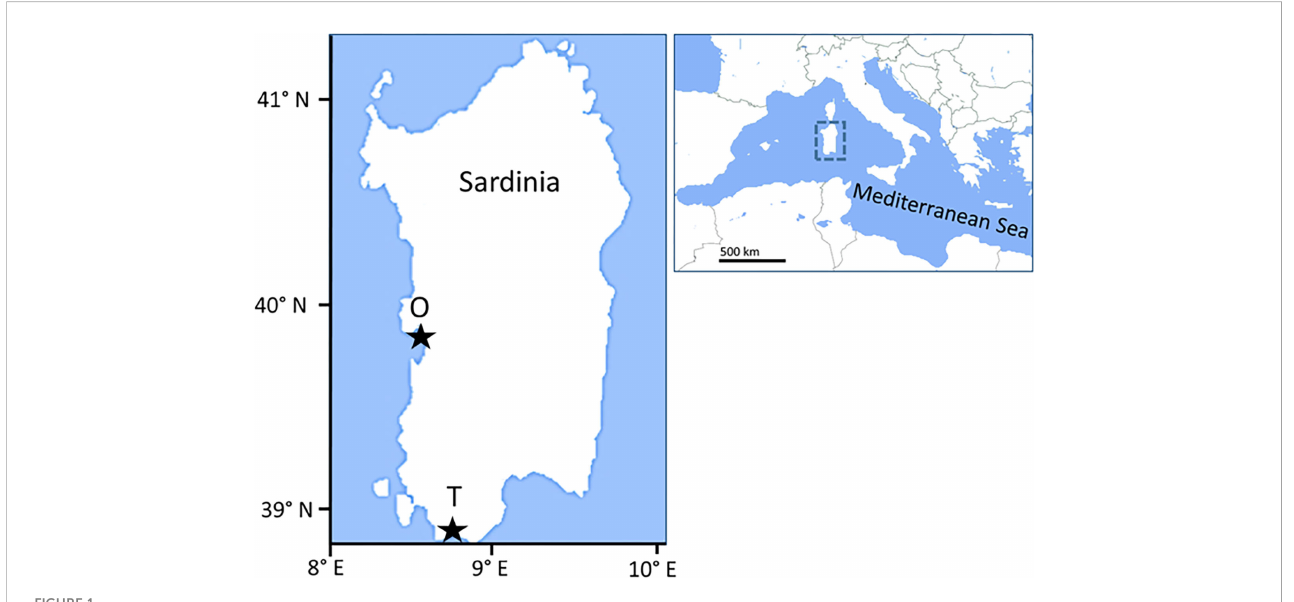
FIGURE 1 Location of the sampling sites in the Oristano (O) and Teulada (T)